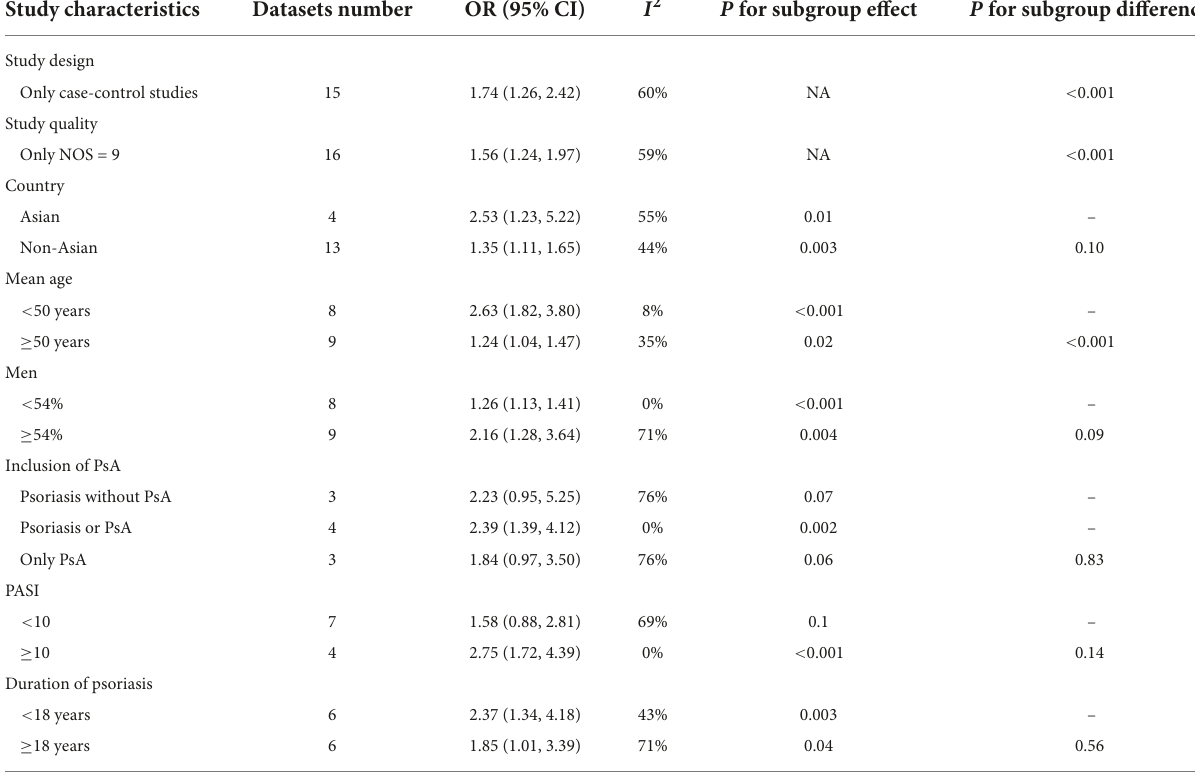
TABLE 3 Results of sensitivity and subgroup analyses of the association between psoriasis and coronary artery calcification (CAC). Study